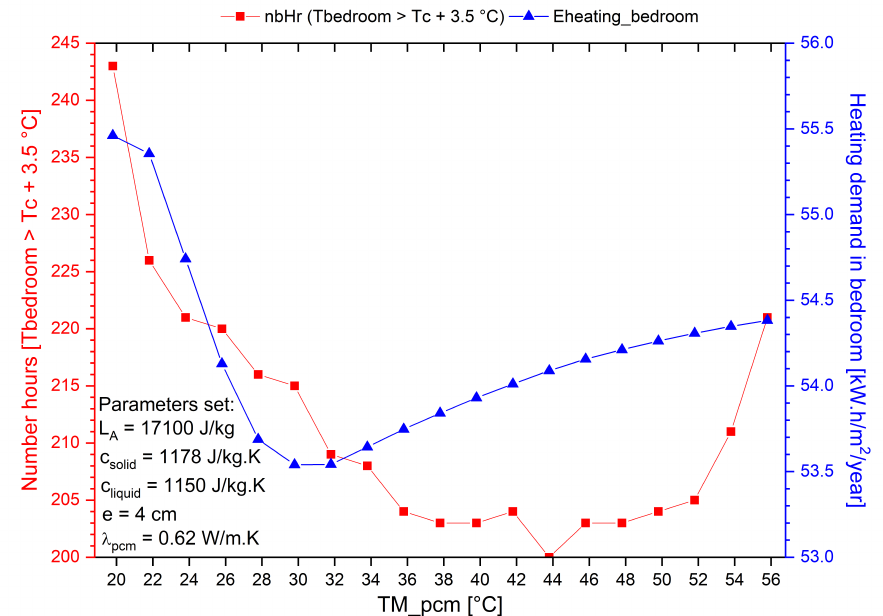
Figure 13. Number of hours of thermal discomfort and heating demand vs. melting temperature during the cold season (7 months total: January–April and October–December).